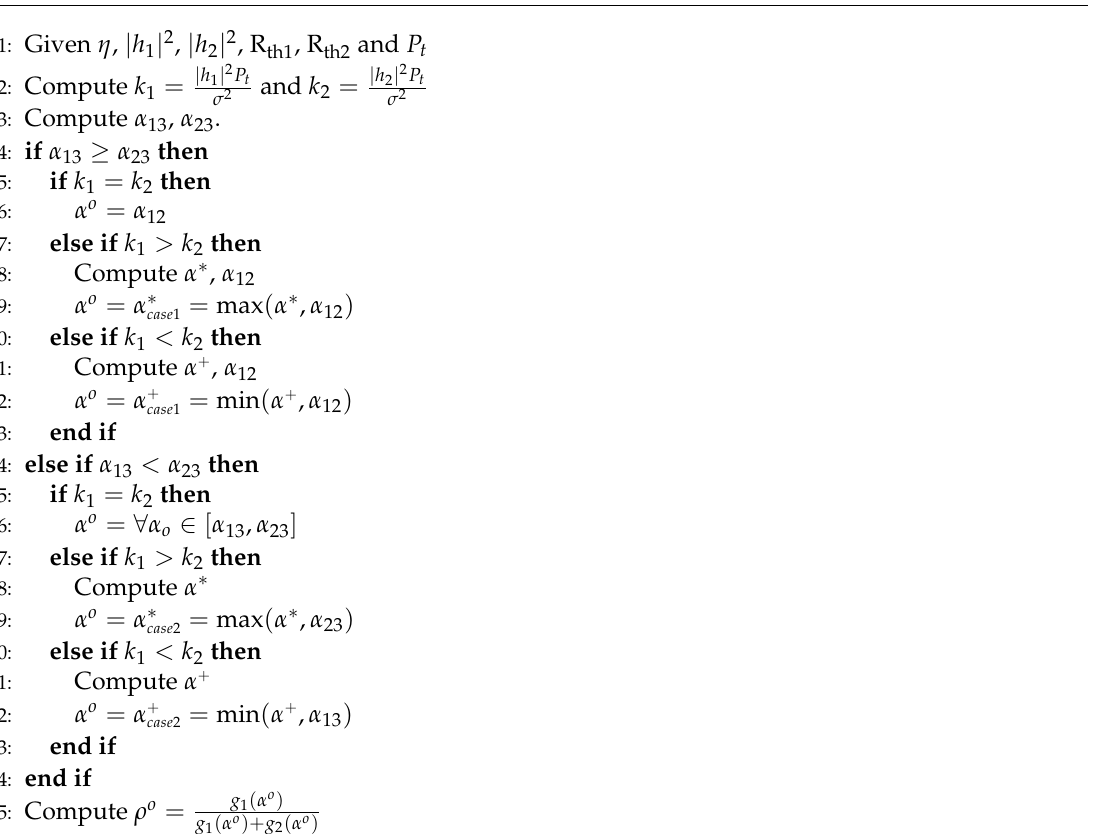
Algorithm 1 summarizes the optimal power allocation ratio and power splitting ratio design for a given set of η , | h 1 | 2 , | h 2 | 2 , R th1 , R th2 and P t . Algorithm 1 Optimal joint resource allocation for α o , ρ o